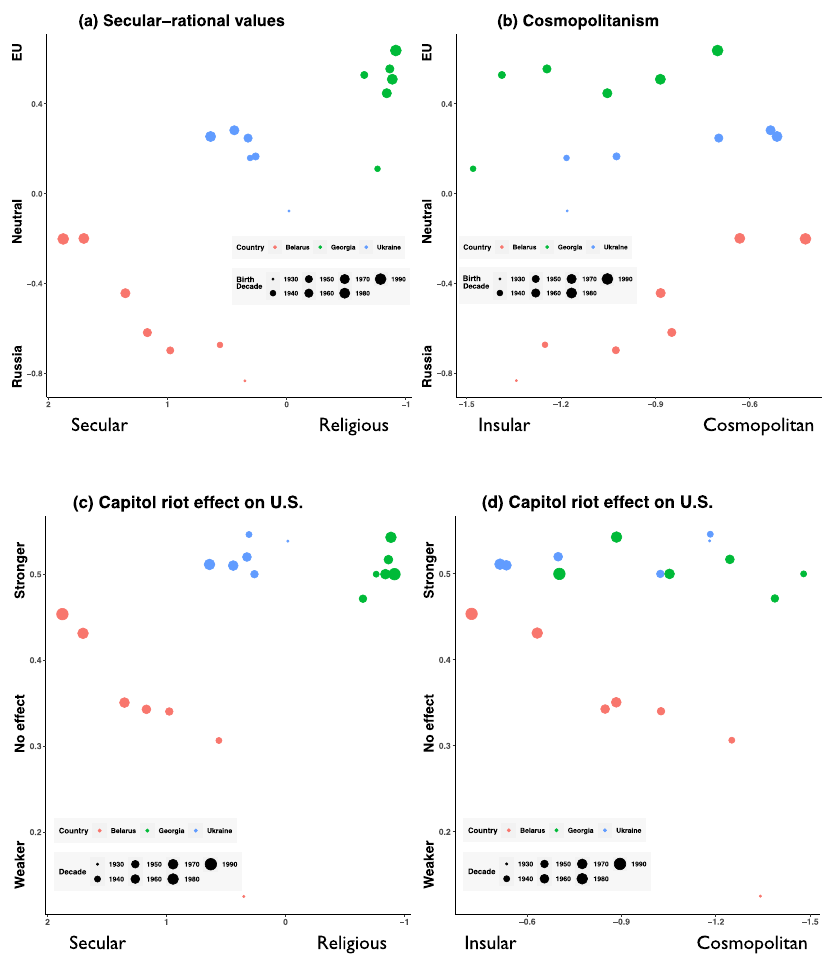
Fig. 3 Attitude on the future political alignment of the country versus (a) Secularism and (b) Cosmopolitanism, in FSRs. Optimism about the U.S. after the Capitol riot versus c Secularism and d Cosmopolitanism in FSRs. The size of each data point represents the decade of birth, where the smallest is 1930 and the largest is